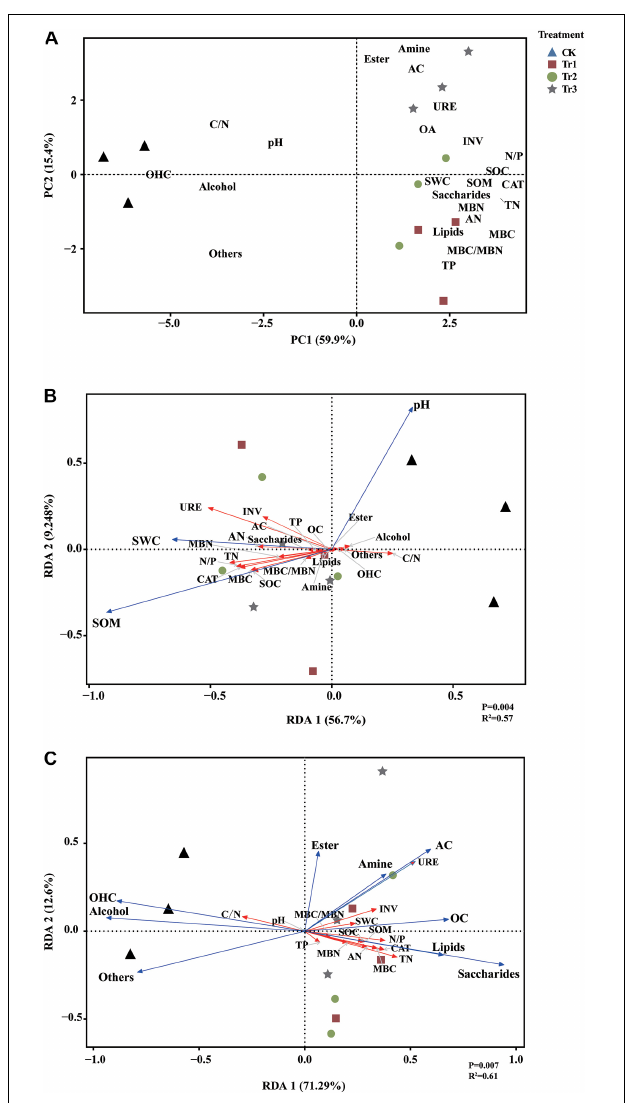
FIGURE 2 | Principal component analysis (PCA) based on the root exudates, soil physicochemical parameters and soil nutrients (A) and redundancy analysis (RDA) of soil nutrient variables constrained by basic physicochemical parameters (pH, SWC, and SOM) (B) and by root exudates (C)